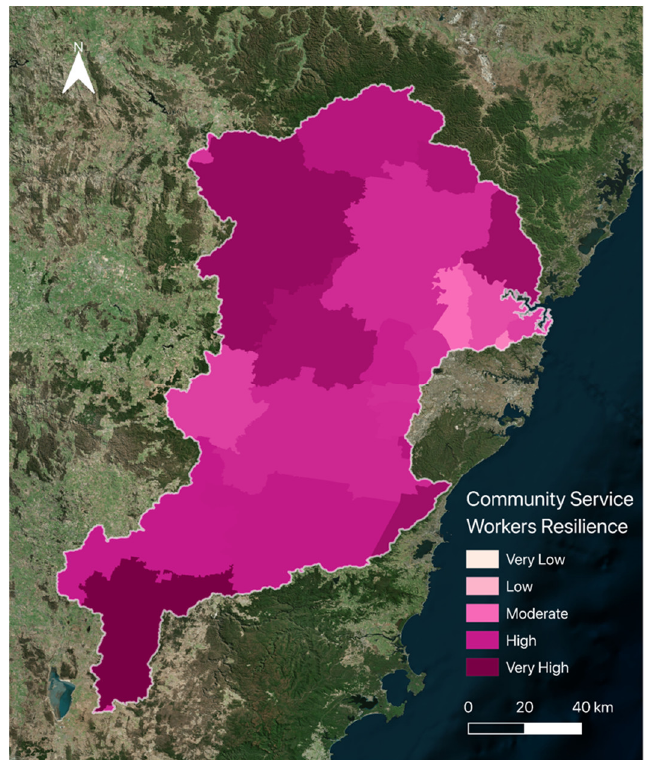
Figure 7. Tertiary Qualification Resilience after standardising using fuzzy membership processing. Resilience measured from Very Low (light pink) to Very High (dark pink).